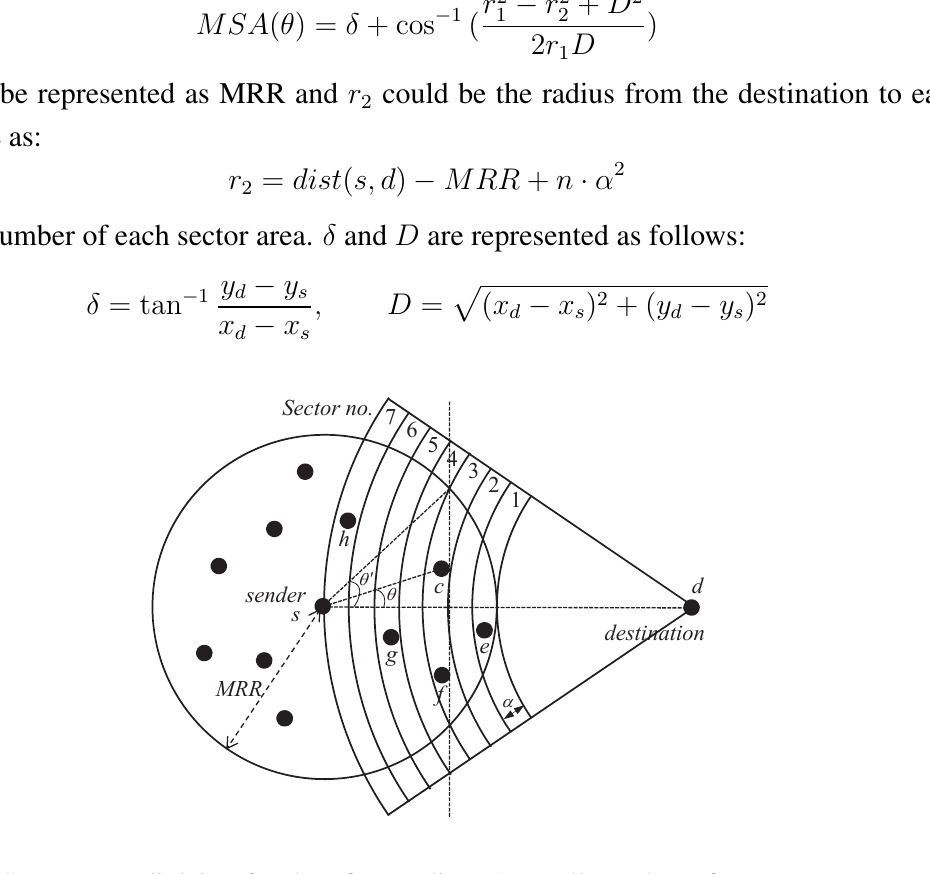
Figure 5. Sector area division for data forwarding. A small number of sectors means a short timer. e , g and h are Sectors 1, 5 and 7, respectively, whereas c and f are Sector